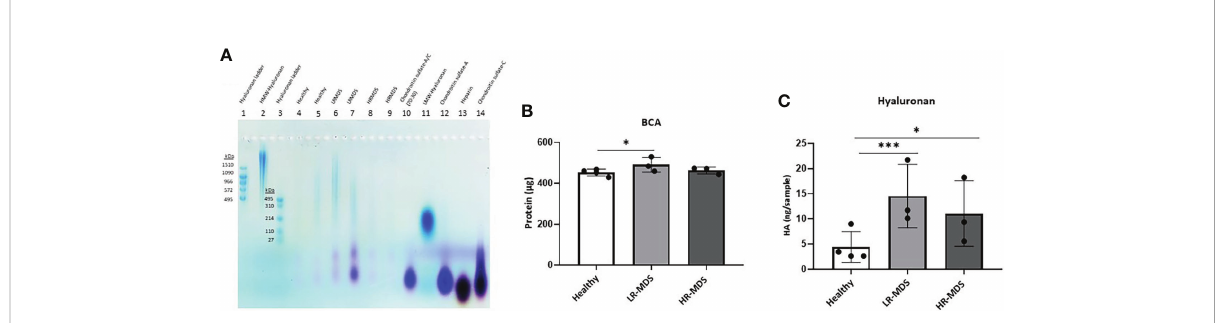
FIGURE 3 HA analysis in ECM samples. (A) Representative images of the stains all gel staining to characterize different GAGs in the ECM from each sample group. (B) Quanti fi cation of total protein of the ECM from healthy donor, LR-MDS and HR-MDS MSC using BCA assay. (C) Total HA quanti fi cation of the ECM from each sample group using ELISA. Bars represent mean ± SD in triplicate for N=4 for healthy donor MSC derived ECM and N=3 for per MDS sample group. *p< 0.05, ***p< 0.001 analyzed by one-way